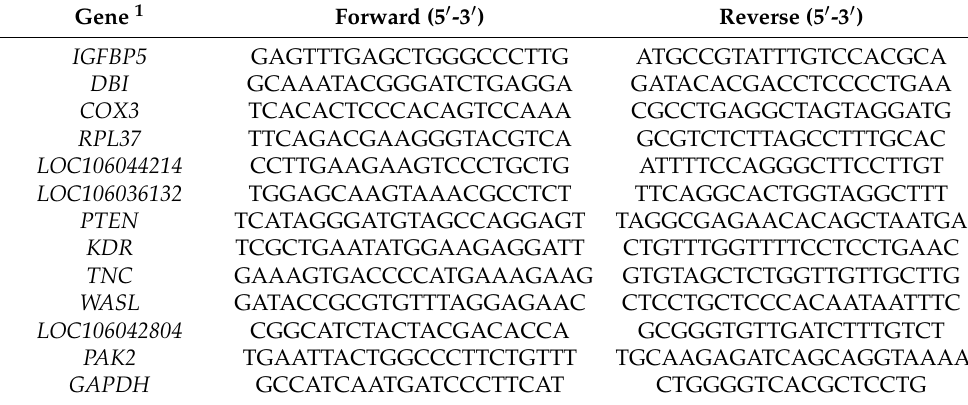
Table 2. Information on the primer sets used in quantitative PCR